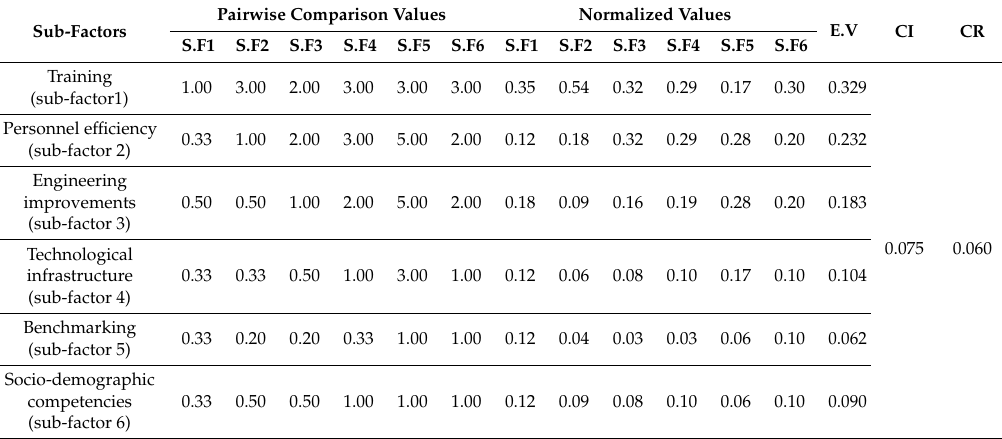
Table A2. The results for the pair-wise comparison of sub-factors with respect to factor 2. Pairwise Comparison Values Normalized Values Sub-Factors S.F1 S.F2 S.F3 S.F4 S.F5 S.F6 S.F1 S.F2 S.F3 S.F4 S.F5 S.F6